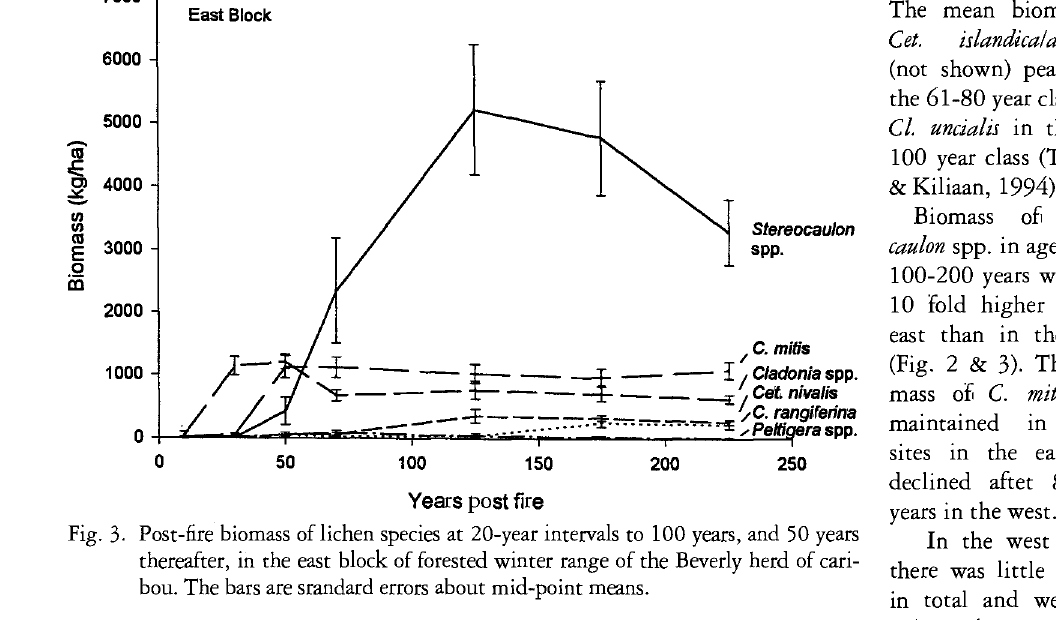
Fig. 3. Post-fire biomass of lichen species at 20-year intervals to 100 years, and 50 years thereafter, in the east block of forested winter range of the Beverly herd of cari bou. The bars are srandard errors about mid-point means.